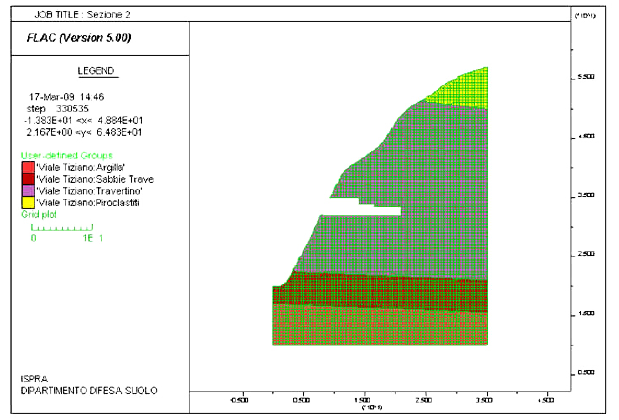
Fig. 13. Geometrical 3-D model. The 3-D model is included in a box of 100 × 50 × 220m. Caves shapes have been drawn at the base of the slope, then moved at the right altitude through the method- ology of moving meshes. Generic tetrahedral type elements were used; the degree of freedom for the system is equal to